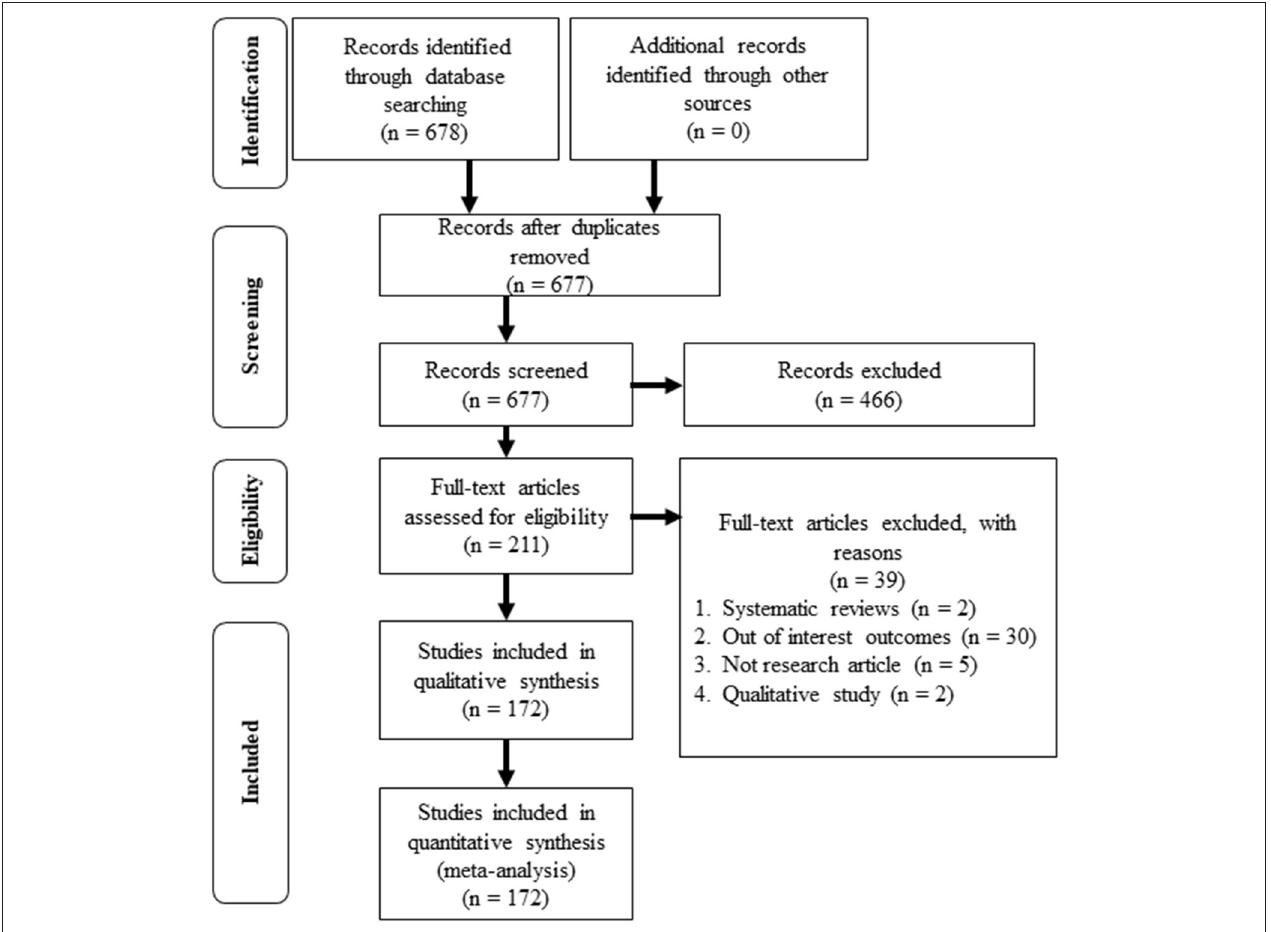
FIGURE 1 | PRISMA flowchart of the